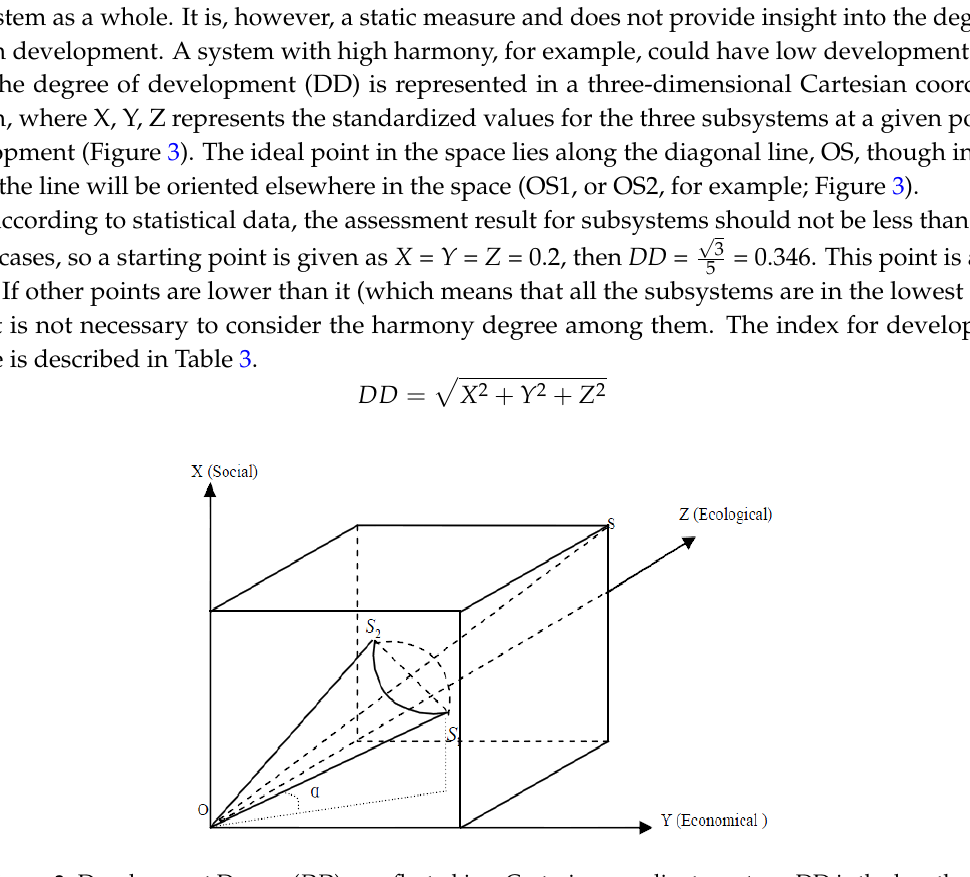
Figure 3. Development Degree ( DD ) as reflected in a Cartesian coordinate system. DD is the length of the line from the origin to the point of intersection in the X , Y , Z space (see text for more details). Table 3. Index and degree of development (DD).